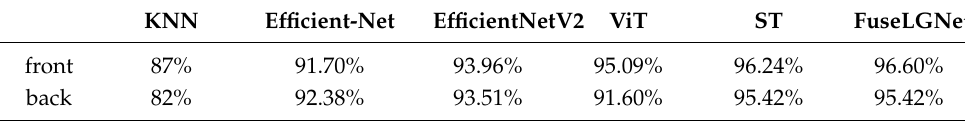
Table 4. Results from gait energy maps using the GAIT-IT dataset.